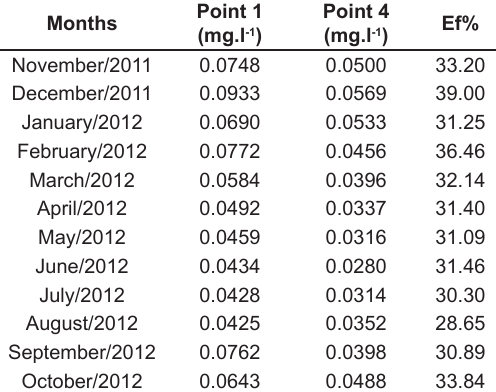
Table 3. Efficiency retention of total phosphorus in points 1 and